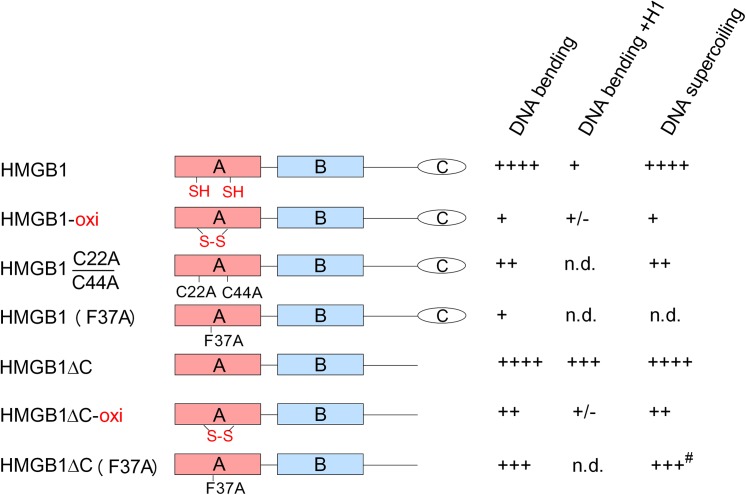
HMGB1 and peptides.(top) HMGB1 organization (amino acid residues 1–214; A, domain A; B, domain B; C, acidic C-tail), and (below) HMGB1 mutants and domains. HMGB1ΔC (amino acid residues 1–185). Positions of mutations are indicated. Data obtained with individual HMGB proteins are summarized on the right. oxi, oxidized. C22A/C44A, Cys at 22 and at 44 mutated to alanine. F37A, Phe at 37 mutated to alanine. #unpublished results. n.d., not determined.